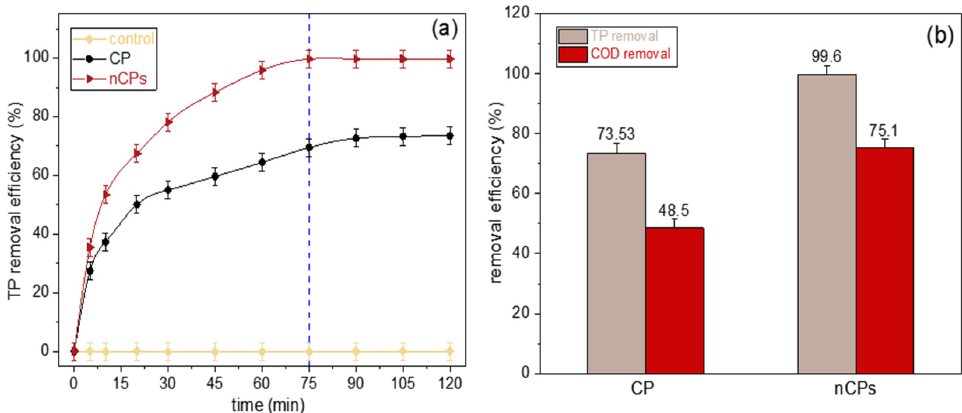
Figure 8. ( a ) The effect of contact time on TP removal based on nCPs using Fenton-based system